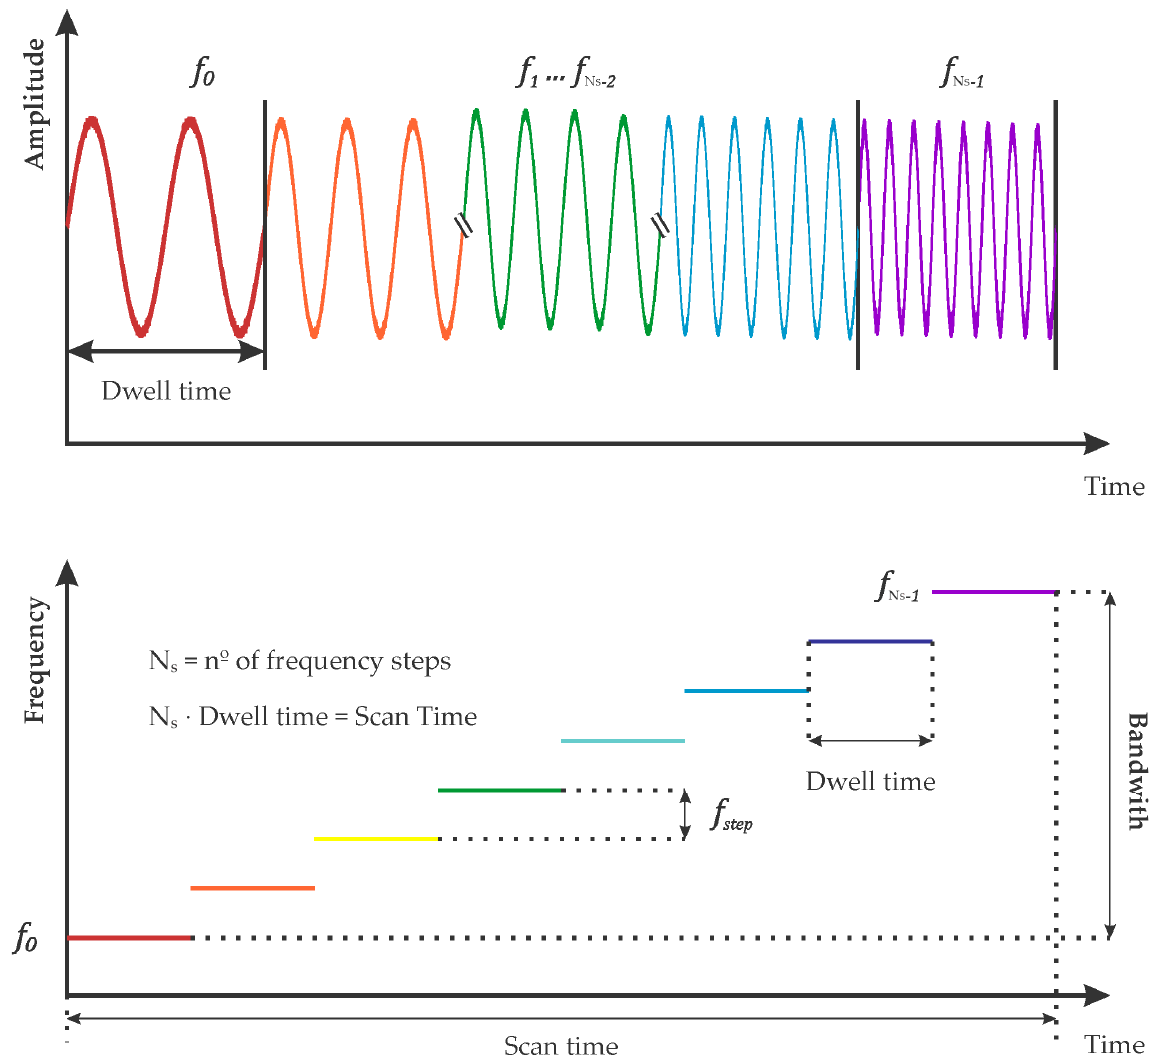
Figure 2. Descriptive diagram of the step-frequency system and all its associated parameters.